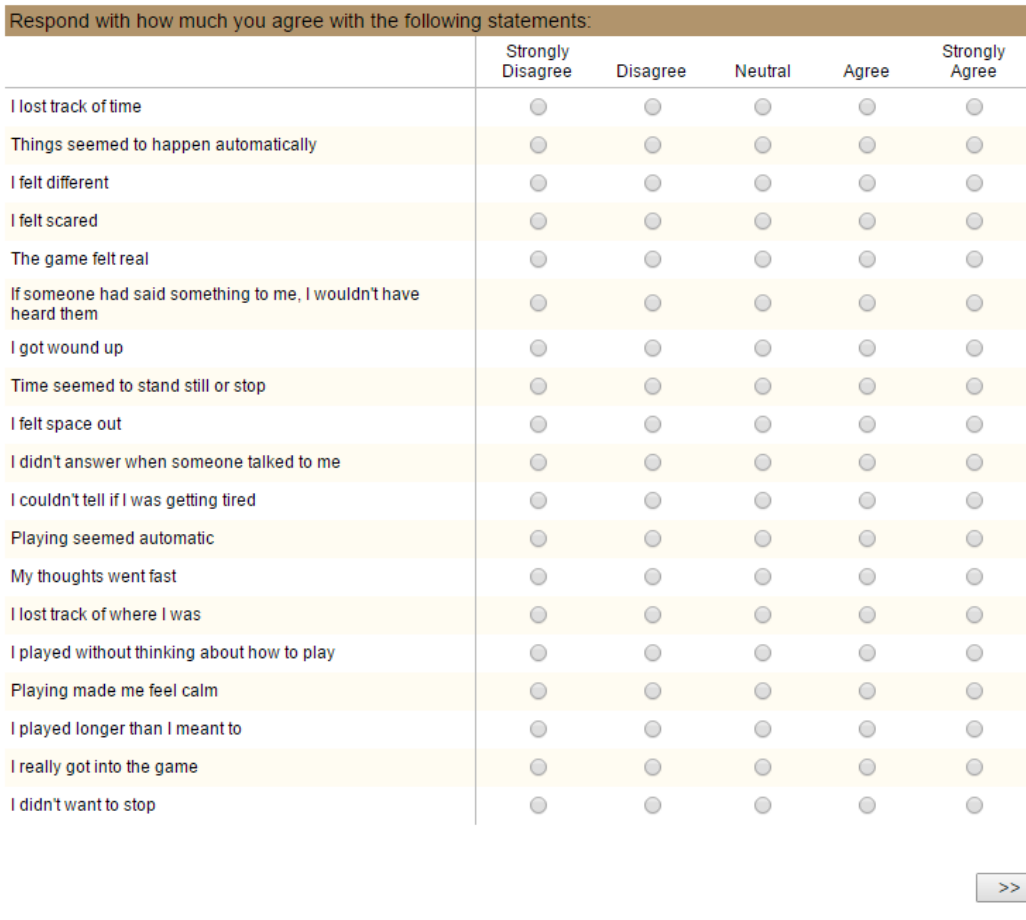
Figure A.1. Modified Game Engagement